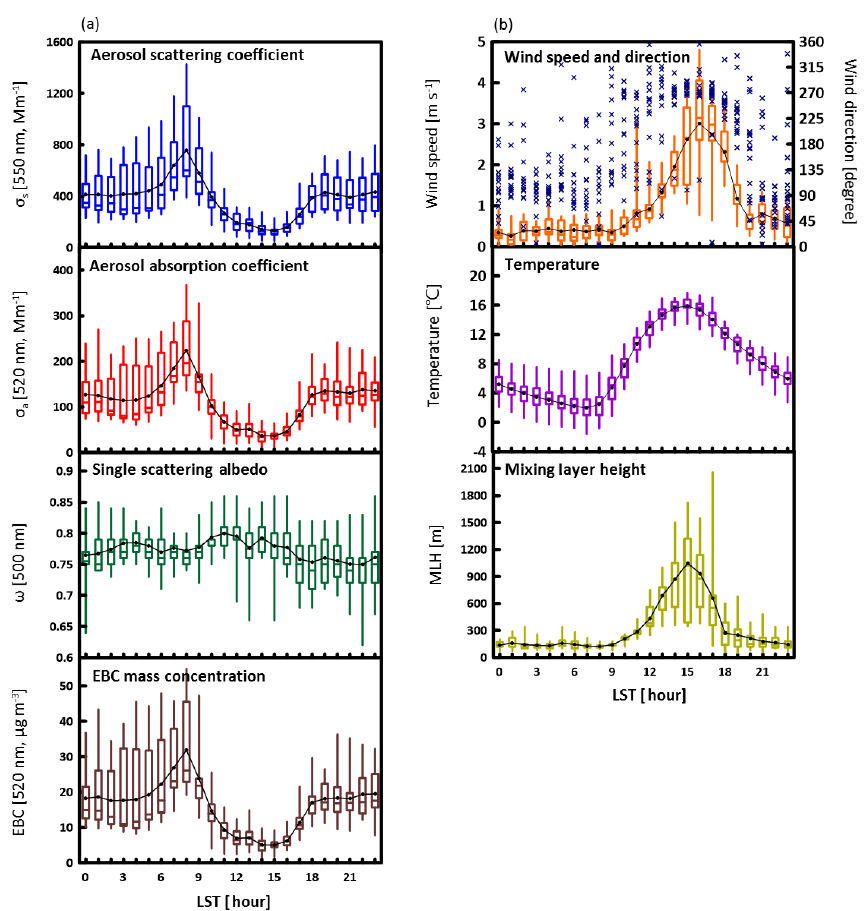
Figure 5. Diurnal cycle of the (a) aerosol optical properties and EBC mass concentration (blue box-whisker; scattering coefficient, red box-whisker; absorption coefficient, green box-whisker; single scattering albedo, brown box-whisker; EBC mass concentration; black lines are mean values) and (b) meteorological parameters (orange box-whisker; wind speed, x symbol; wind direction, purple box-whisker; temperature, yellow box-whisker; mixing layer height; black lines are mean values) at Bode in the Kathmandu Valley. Note that the mixing layer height was measured by a ceilometer from 27 January 2013–14 February 2013 (see Mues et al., 2017 for more information on ceilometer measurements at